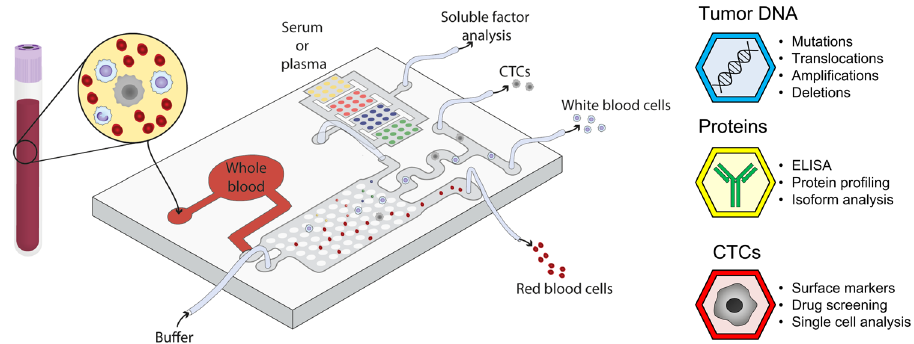
Fig. 3 Micro fl uidic models for molecular diagnostics. Theoretical device design for back-to-back analysis of CTCs and circulating proteins and DNA from whole blood. Whole blood is perfused through a series of microchambers and microchannels that leverage several microscale-based separation techniques to isolate multiple components such as immune cells, CTCs, ctDNA, proteins, and exosomes. Next, cells and analytes are either retrieved or analyzed in